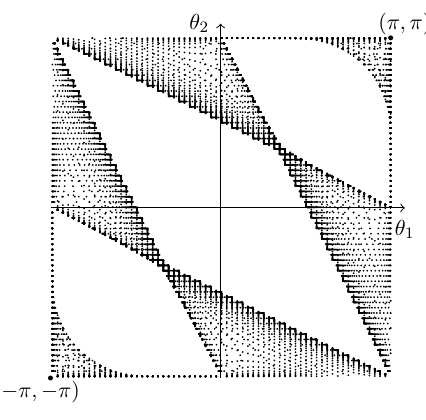
Figure 2 . Coamoeba (shaded) of b = 1 + z 1 z 2 + z 1 z 2